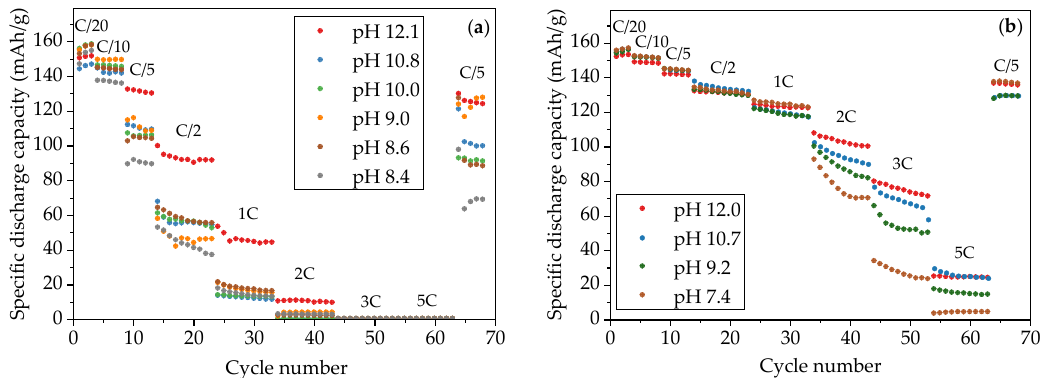
Figure 6. Specific discharge capacity of cells containing ( a ) thick-film electrodes and ( b ) thin-film electrodes produced with different slurry pH values.